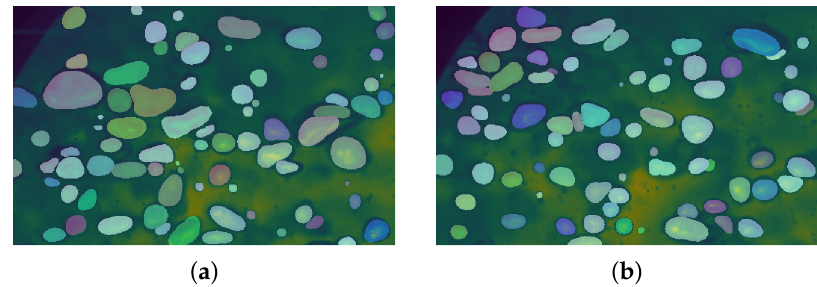
Figure 29. StarDist method application: sample image from training ( a ) and test ( b ) sets.